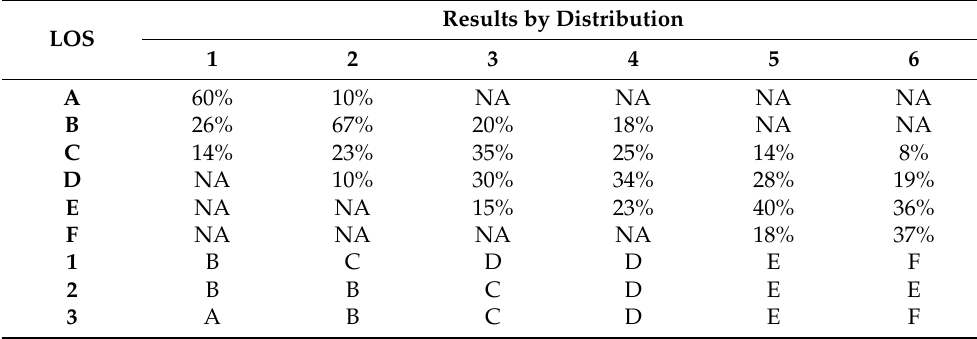
Table 4. Representation of Survey Results by a Single LOS Grade: Distributions and Mean of LOS. Results by Distribution LOS 1 2 3 4 5